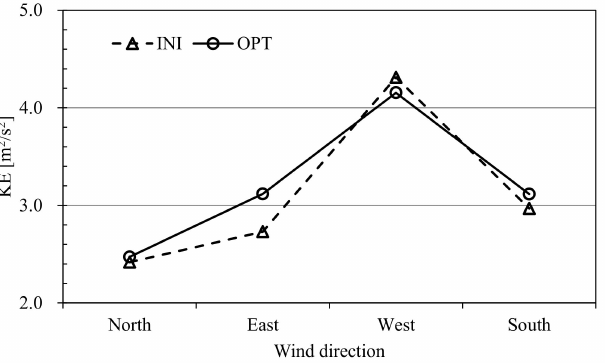
Figure 10. The spatially averaged kinetic energy (KE) in each wind direction for the initial (INI) and optimized design (OPT).